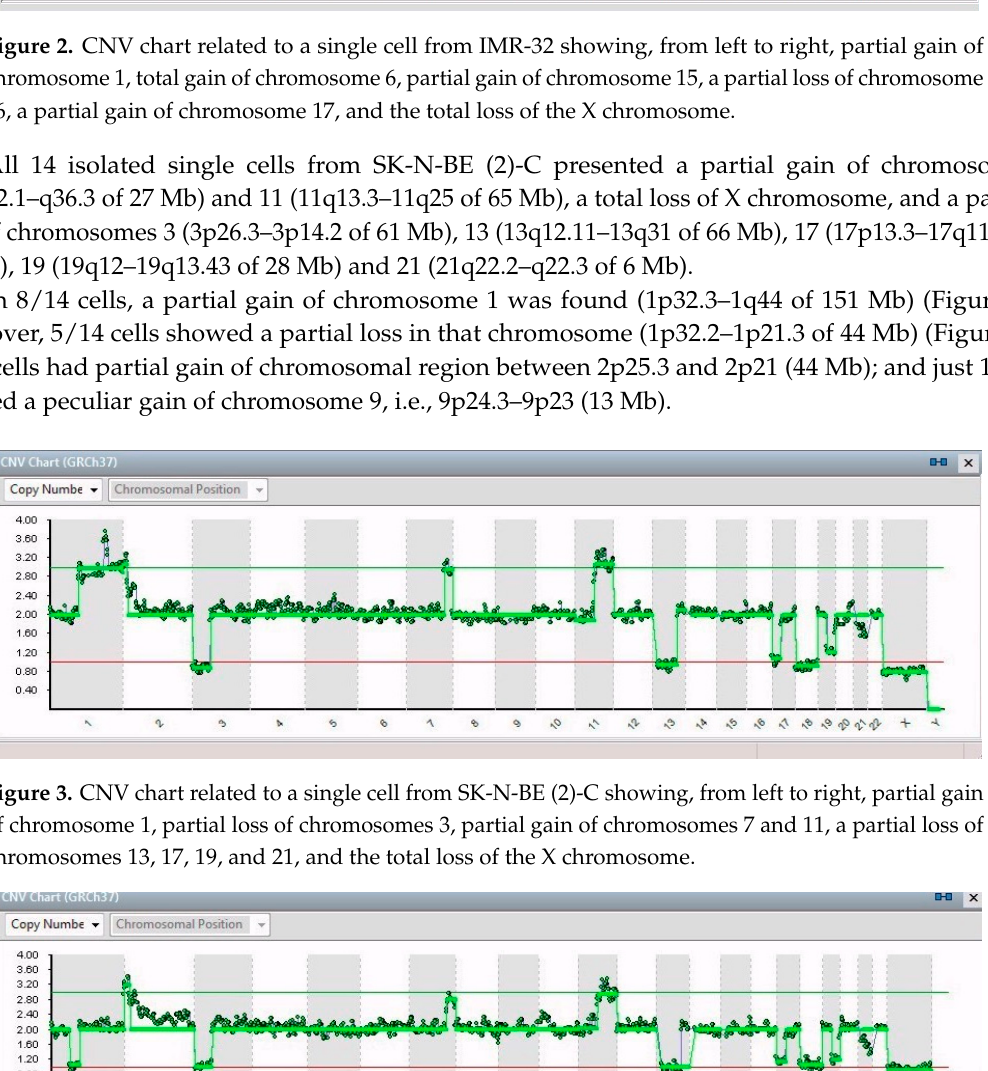
Figure 4. CNV chart related to a single cell from SK-N-BE (2)-C showing, from left to right, partial loss of chromosome 1, partial gain of chromosome 2, partial loss of chromosomes 3, partial gain of chromosomes 7 and 11, a partial loss of chromosomes 13, 17, 19, and 21, and the total loss of the X chromosome.